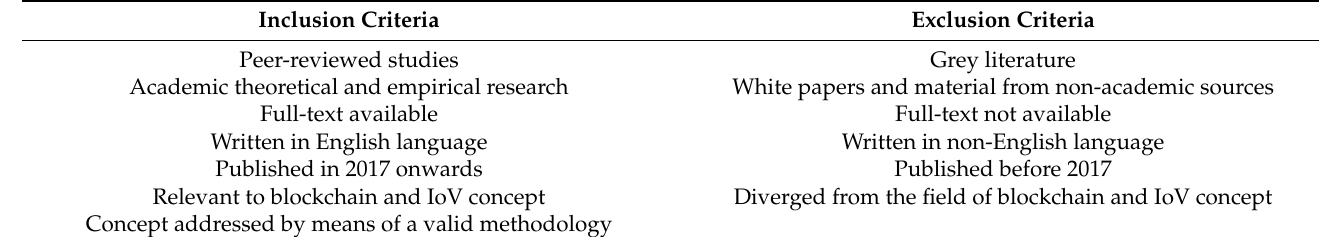
Table 2. Inclusion and exclusion